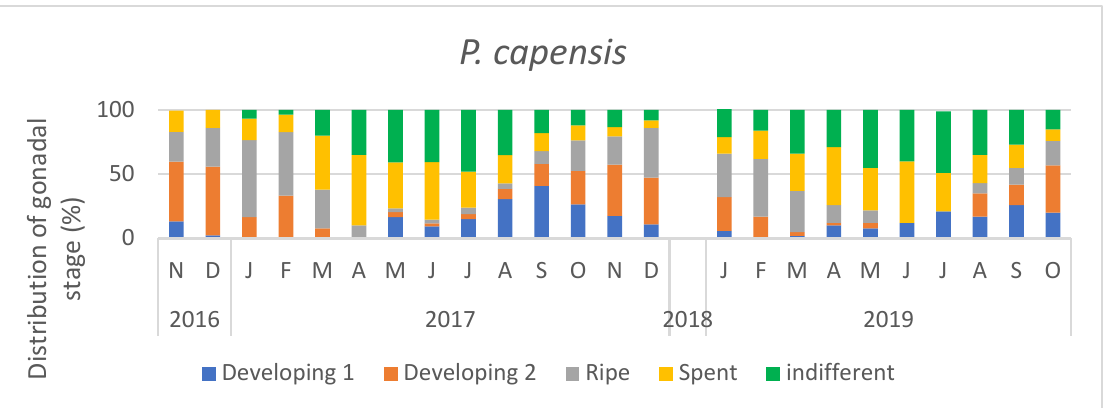
Figure 5. Correlation between temperature and the condition index (CI) of Saccostrea cucullata and Pinctada capensis from Inhaca Island.